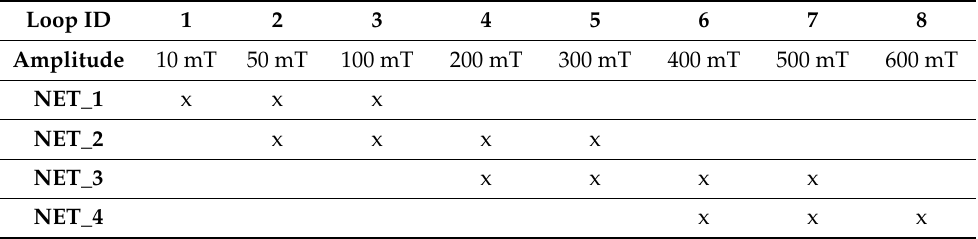
Table 3. Loops for NS identification subdivided into partially overlapping sets for the training of single couples of NNs.